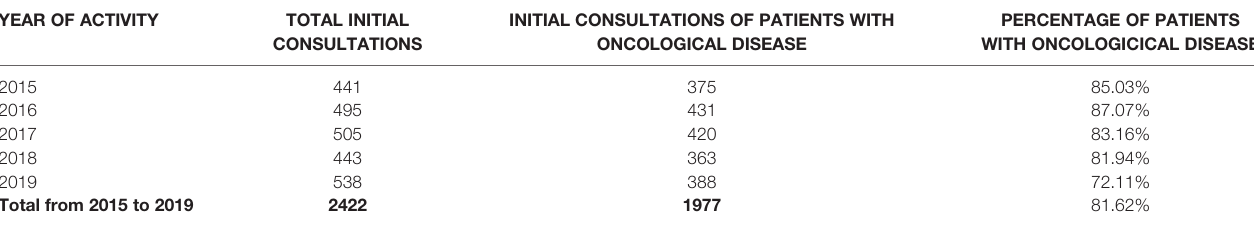
TABLE 1 | Initial consultation from January 2015 to December 2019 and comparison between initial consultation of patients with oncological disease and patients with non-oncological disease. YEAR OF ACTIVITY